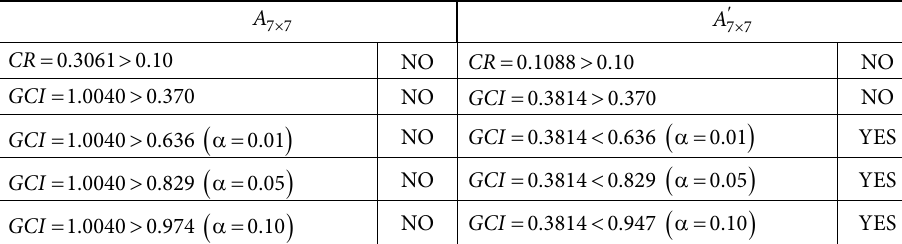
Table 8. The corresponding results for two 7-order